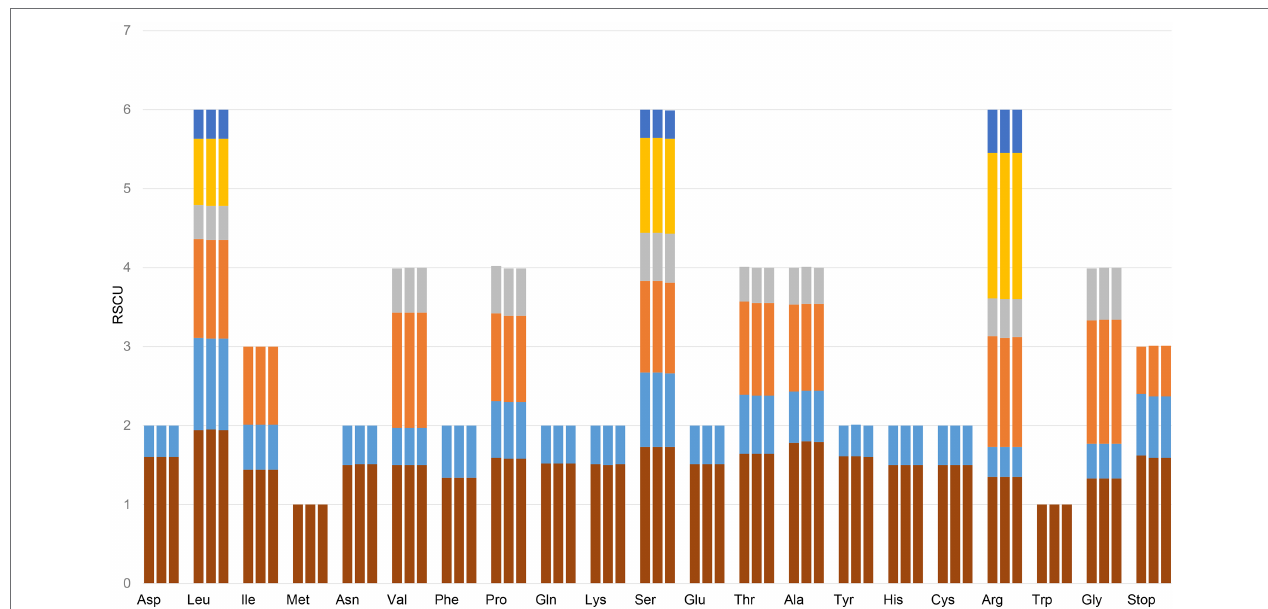
FIGURE 3 | Codon content of 20 amino acid and stop codons in all protein-coding genes of the chloroplast genomes of three species. The histogram from left to right of each amino acid shows codon usage within the chloroplast genomes of C. vaginatum , L. sinense , and L. jeholense